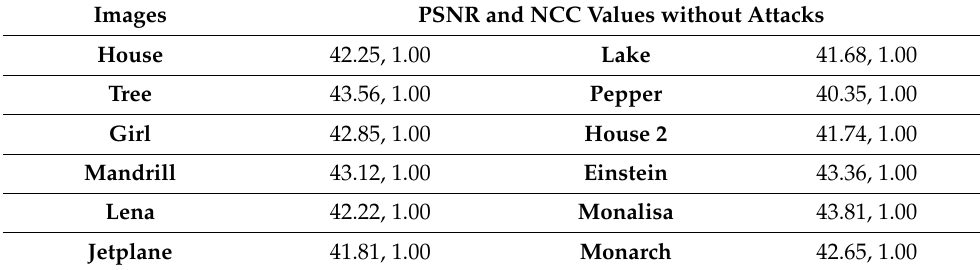
Table 2. PSNR and NCC values without attacks.